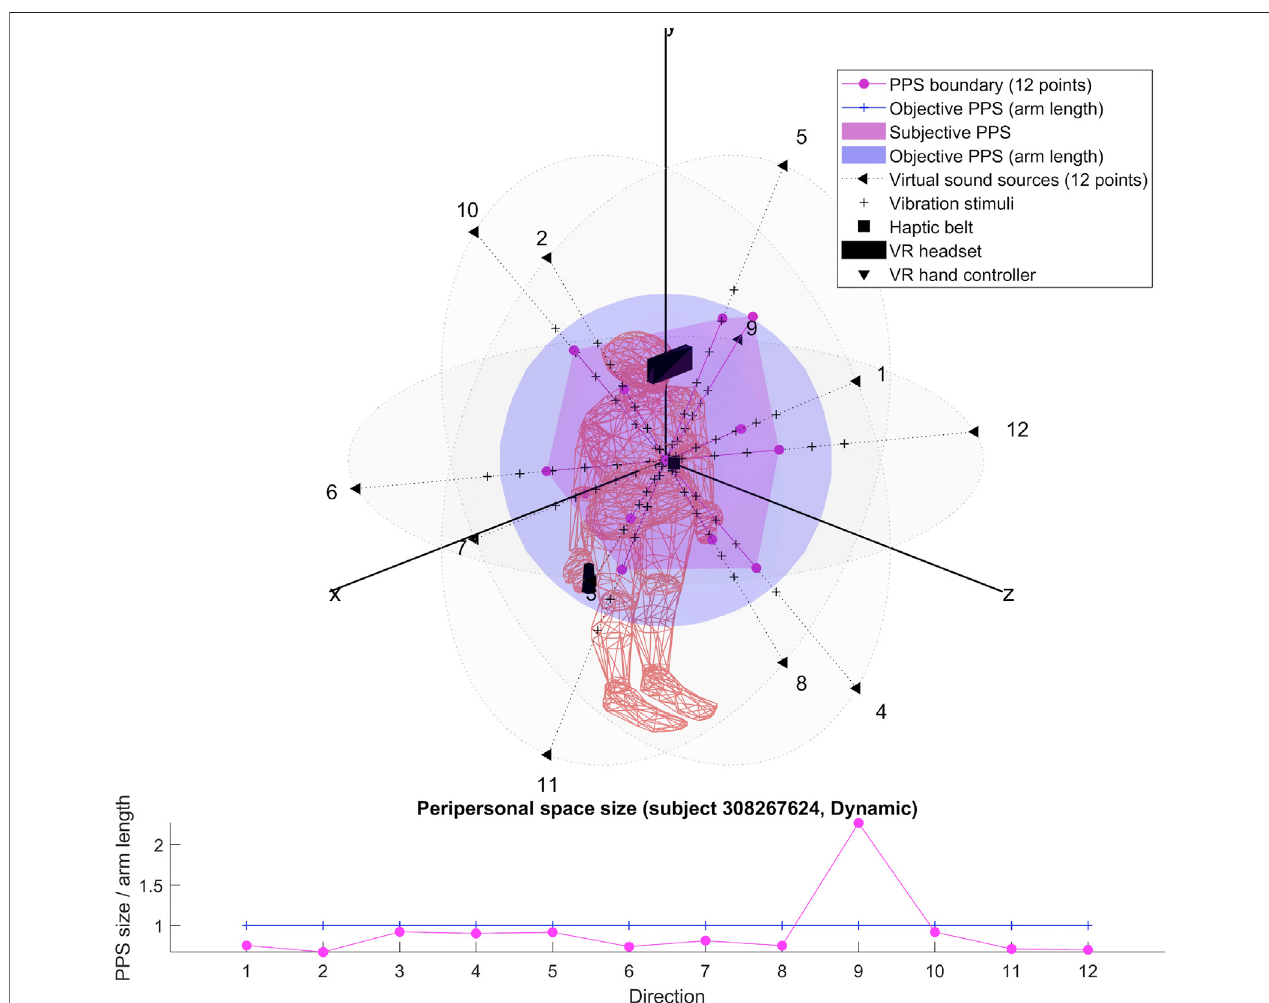
FIGURE 10 | PPS 3D representation for subject 308267624 dynamic